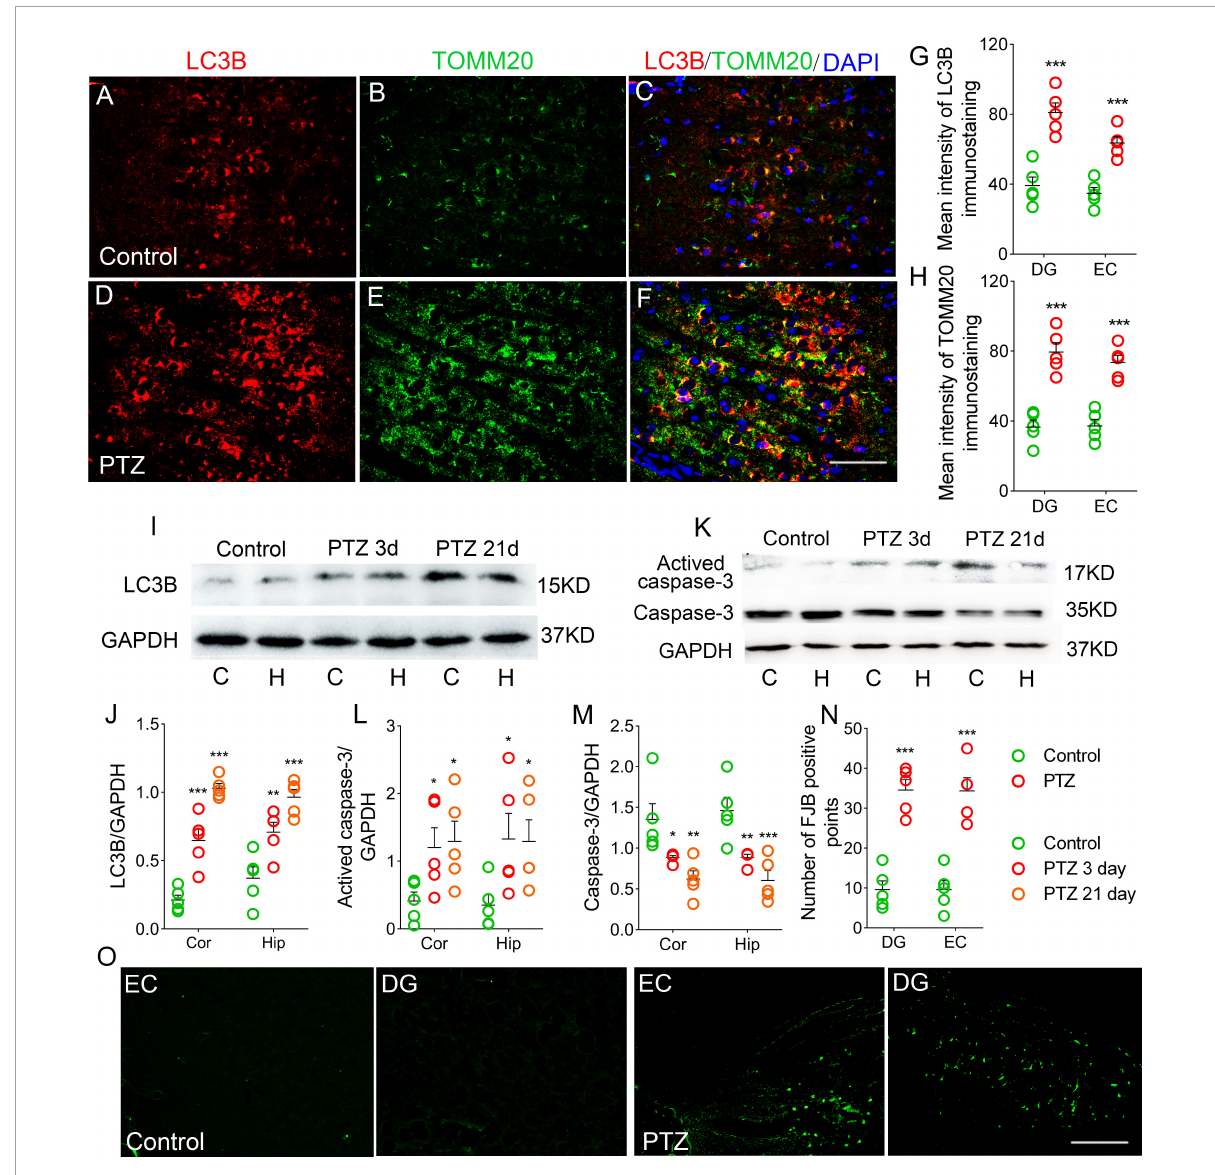
FIGURE4 Increased autophagy/mitophagy and neuronal injury in pentylenetetrazole (PTZ)-induced epileptogenesis. (A–F) Increased fluorescence intensity of LC3B (red) and TOMM20 (green) in the EC region during epileptogenesis ( n = 5/group; blue, DAPI). Bar = 60 µ m. (G,H) Quantified changes in LC3B and TOMM20 ( n = 5/group). (I) Expression of LC3B in the hippocampus and cortex estimated by western blotting ( n = 5/group). (J) Normalized intensity of LC3B relative to GAPDH. (K–M) Levels of caspase-3 and activated caspase-3 in the hippocampus and cortex estimated by western blotting ( n = 5/group). (N,O) Positive FJB signals counted in each group. * P < 0.05 and *** P < 0.001, all compared with controls (panels J–M , one-way ANOVA; the others, unpaired T